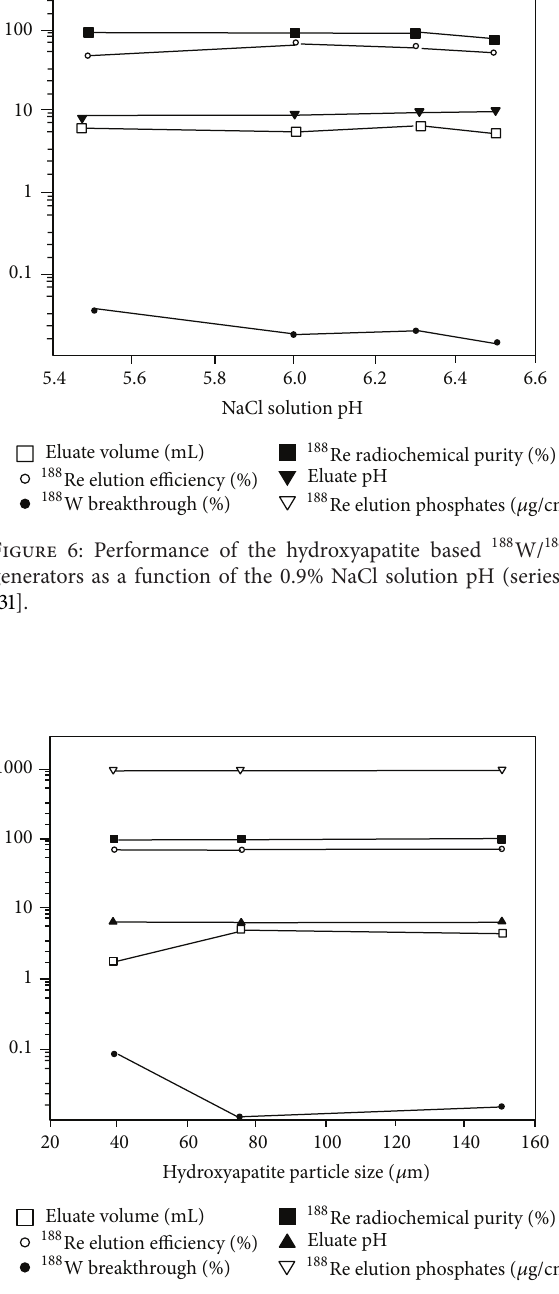
Figure 7: Performance of the hydroxyapatite based 188 W/ 188 Re generators as a function of the hydroxyapatite particle size (series B) [31].